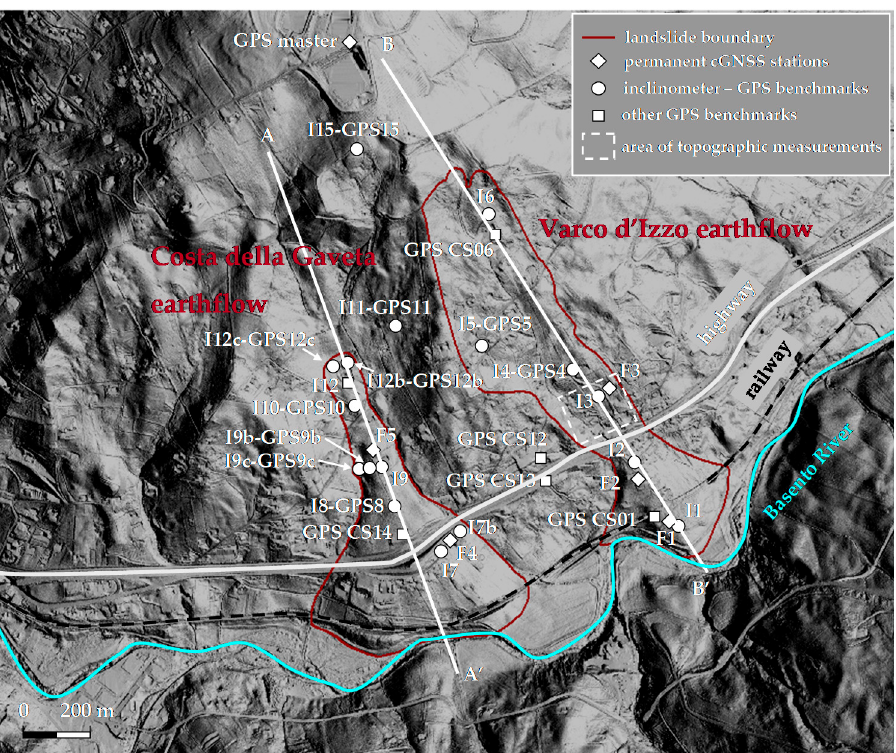
Figure 2. Costa della Gaveta and Varco d’Izzo earthflows and location of inclinometers, GPS stations and benchmarks, and area of topographic measurements.